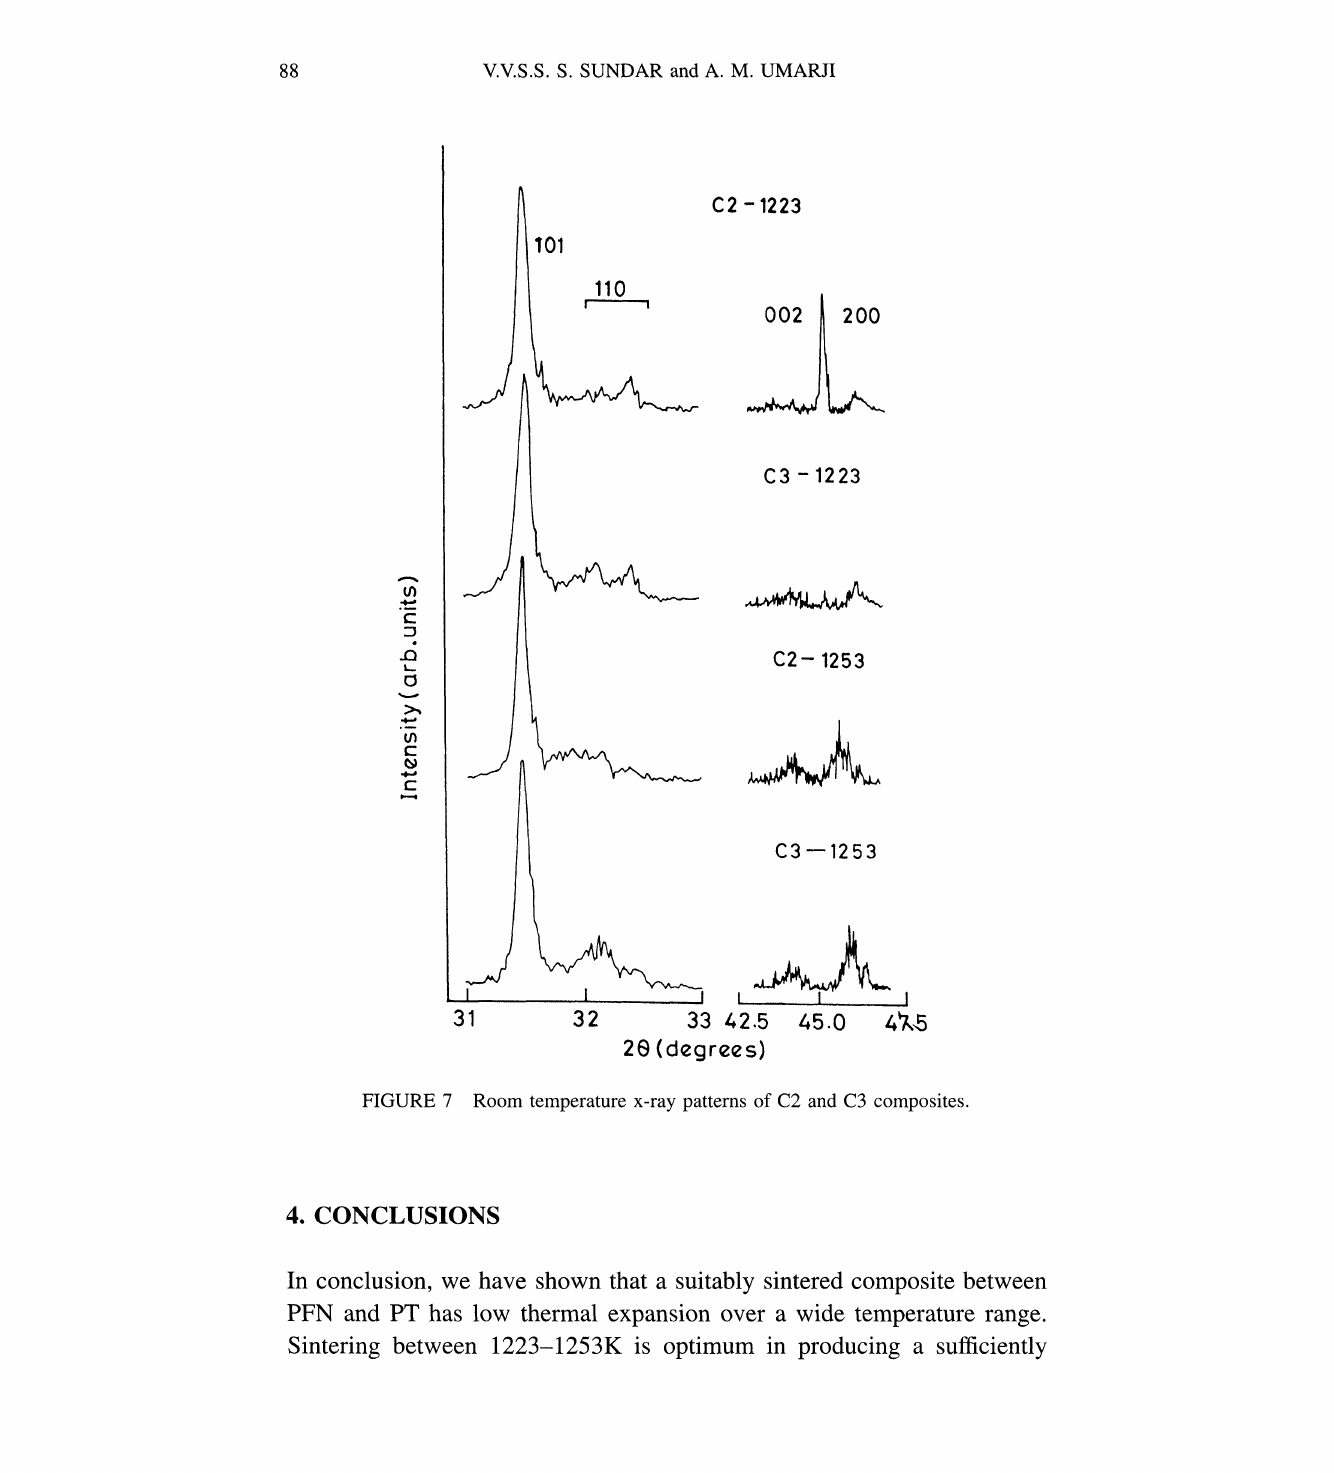
FIGURE 7 Room temperature x-ray patterns of C2 and C3